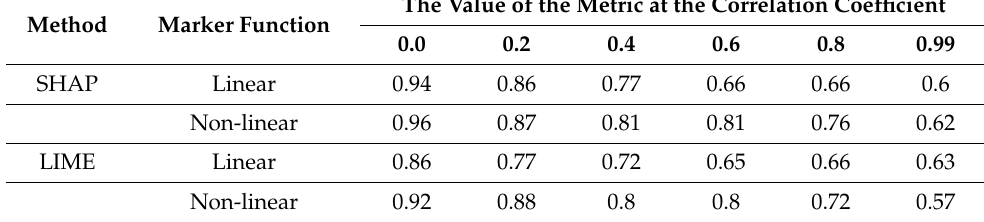
Table 5. Confidence metric for a linear regression model.